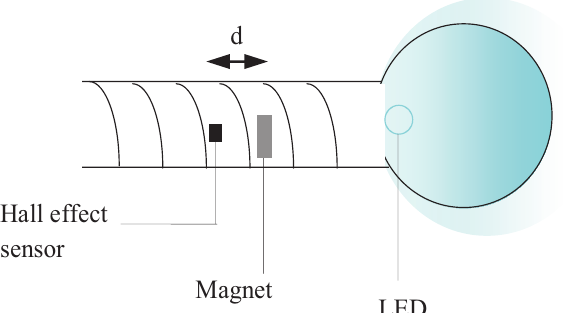
Figure 3. Stretch sensor structure: variations in the distance between the hall effect sensor and the magnet are used to detect